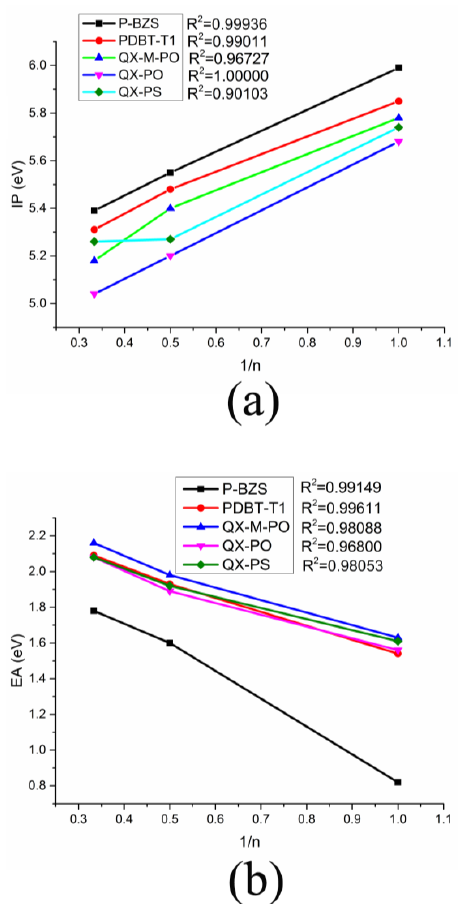
Figure 6. The relationship between the IPs and EAs of the polymers and the reciprocal of the conjugated chain (1/ n ), where ( a , b ) corresponding to IP and EA, respectively.